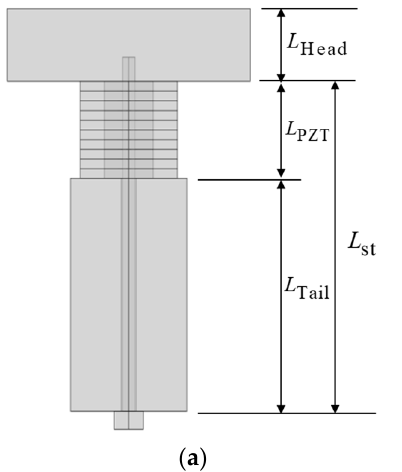
Figure 4. Cylindrical array surrounded by an oblate spheroid acoustic window: ( a ) Geometry. ( b ) FE-BE coupling model. ( c ) Conventional FE model.